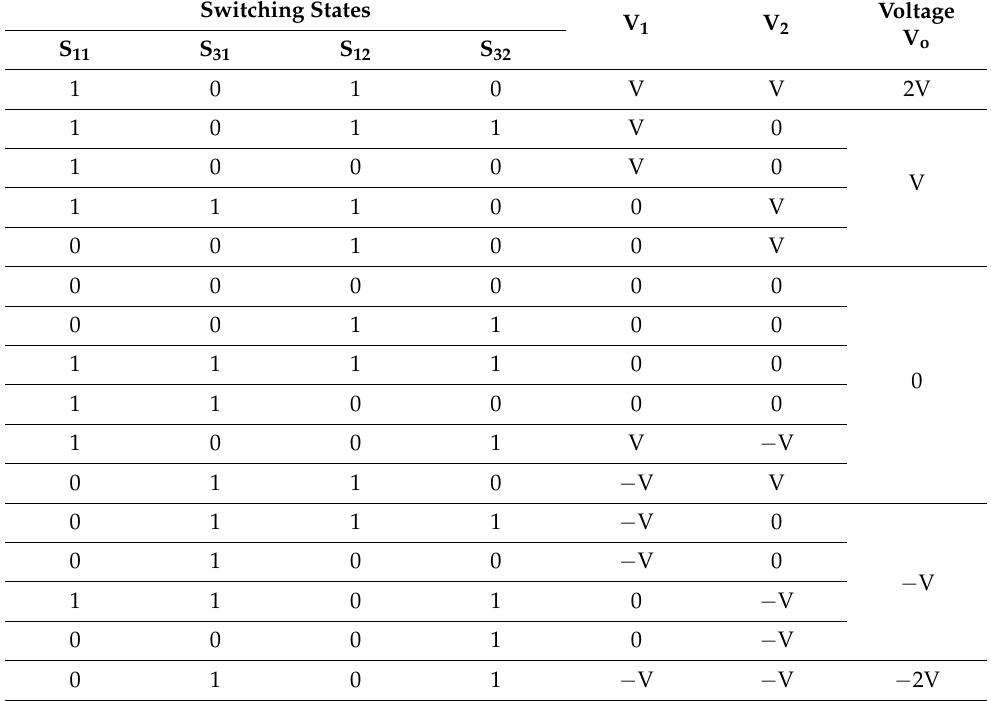
Table 6. Switching pattern of the switches used in CHB-MLI.